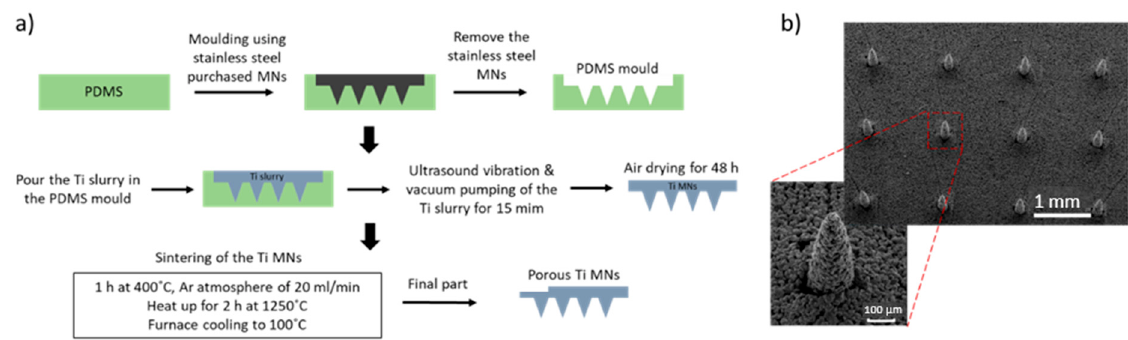
Figure 11. ( a ) Fabrication process of porous Ti MNs, including the fabrication of a PDMS mold, the vacuum pumping of the Ti slurry and the sintering with Argon gas continuously blowing during the sintering process. ( b ) 6 × 6 porous Ti MN arrays fabricated by the metal injection molding process with 500 µm height and 30.1% porosity [28]. Table 3. Overview of the MNs fabrication techniques described in the “Fabrication Methods for Metallic MNs” section.